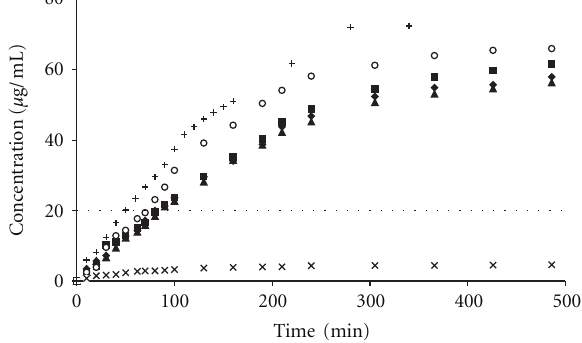
Figure 5: Influence of the type of polymer in the donor compart- ment on the CX concentration in the acceptor medium at 37 ◦ C. The release from respective preparations was depicted: pNIPAM- A-CX( (cid:2) ), pNIPAM-B-CX ( (cid:3) ), pNIPAM-C-CX ( (cid:4) ), MC-CX ( ◦ ), PA-CX ( × ), and aqueous dispersion of CX (+), data from repeated six experiments. The dashed straight line, parallel to the x -axis, represents the MIC of CX for Staphylococcus mutans .